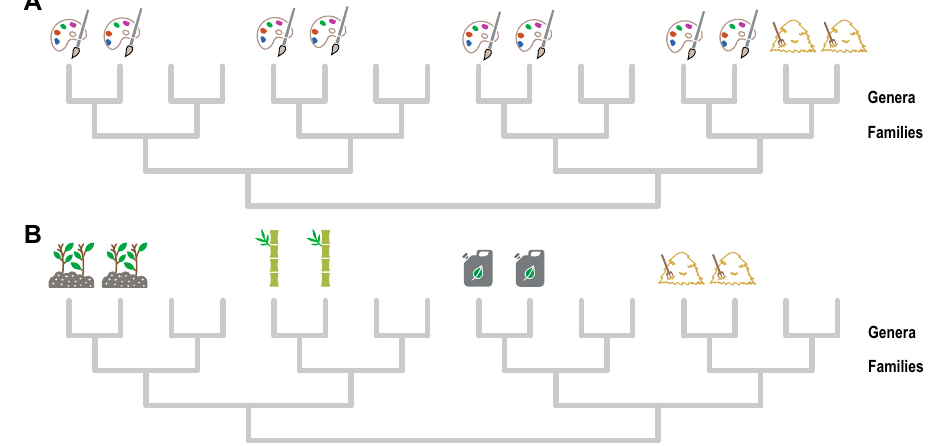
Figure 2. Hypothetic representation of plant benefits in the phylogeny. Phylogenetic nodes representing the same taxonomic rank (genus or family) are placed at the same height in the tree. ( A ) In this example, the benefit ‘dyestuffs’ is clumped in phylogenetically overdispersed genera belonging to four different families, while the benefit ‘fodder’ is uniquely provided by one genus. Assuming that the distribution of these benefits in the phylogeny were unknown and a conservation capacity limited to four species, a PD max sampling strategy could be desirable for capturing species providing dyestuffs relative to an alternative strategy aimed at preserving, for example, one single family. This is because the PD max regime will sample one species per family and thus a maximum of four dyestuff plants, whereas the family-restricted strategy will capture a maximum of two dyestuff plants. In contrast, the PD max regime will always fail to capture the maximum possible number of fodder plants because only one fodder species could be sampled. ( B ) The plant benefits ‘soil improvers’, ‘cane’, ‘biofuel’ and ‘fodder’ are differentially provided by family clades (high phylogenetic turnover between the benefits), and thus the probability that PD max scores four different benefits ( P = 0.5 4 = 0.0625) when sampling four species is almost one order of magnitude higher than that of getting the same result at random ( P = 16/1820 =